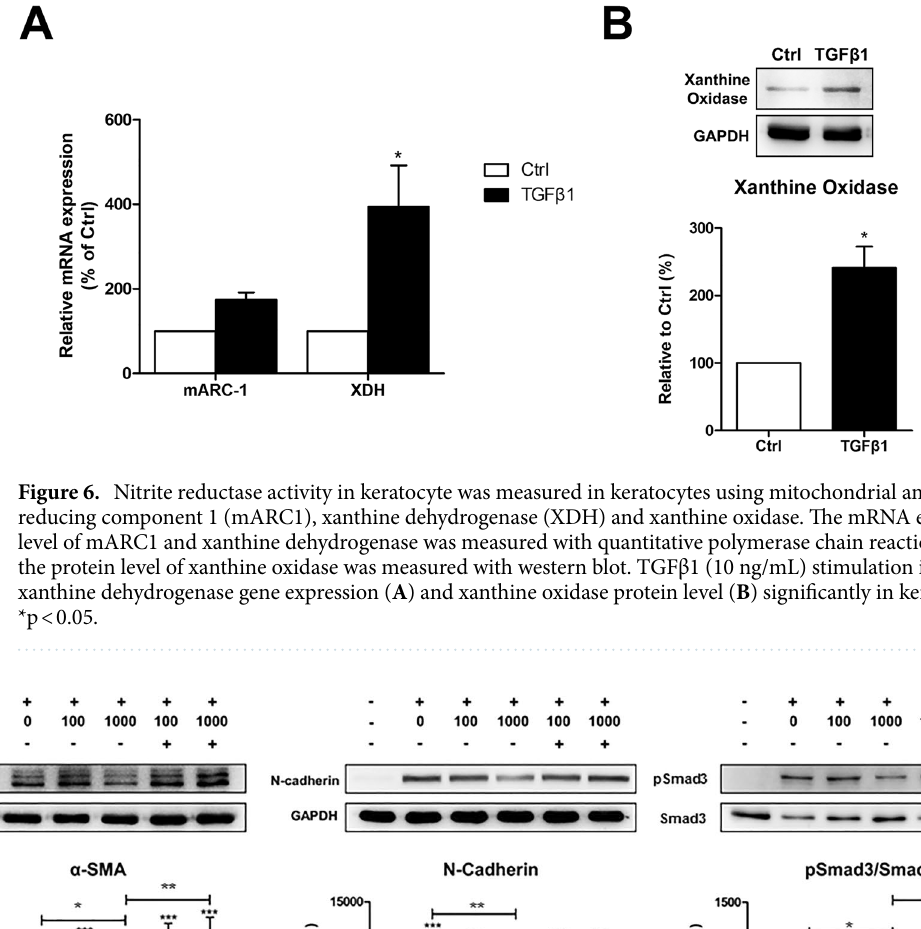
epithelial cell healing after the mechanical injury 30 . Haze control after photorefractive keratectomy can be another implication of exogenous NO treatment because activation of stromal myofibroblasts was known as the main cause of delayed corneal haze after PRK 25 . Although mitomycin C (MMC) is wildly used to prevent corneal haze in the clinical setting, the long term safety issue of MMC has yet to be verified 31,32 . An ideal therapeutic agent to prevent post PRK corneal haze should be safe for keratocytes and can specifically block myofibroblast differentia- tion. In this respect, NO can be a promising candidate when considering its safety and efficacy. Sodium nitrite not only stimulates cGMP production, but also promotes S-nitrosylation of cellular proteins by forming RSNO 33,34 . As shown in our study (Supplement Fig. S3), addition of sodium nitrite in TGFβ1-stimulated keratocytes significantly increased RSNO production, which can increase S-nitrosylation of corneal proteins. Investigation of protein functional change by NO induced S-nitrosylation in cornea can be an interesting topic for the future study.